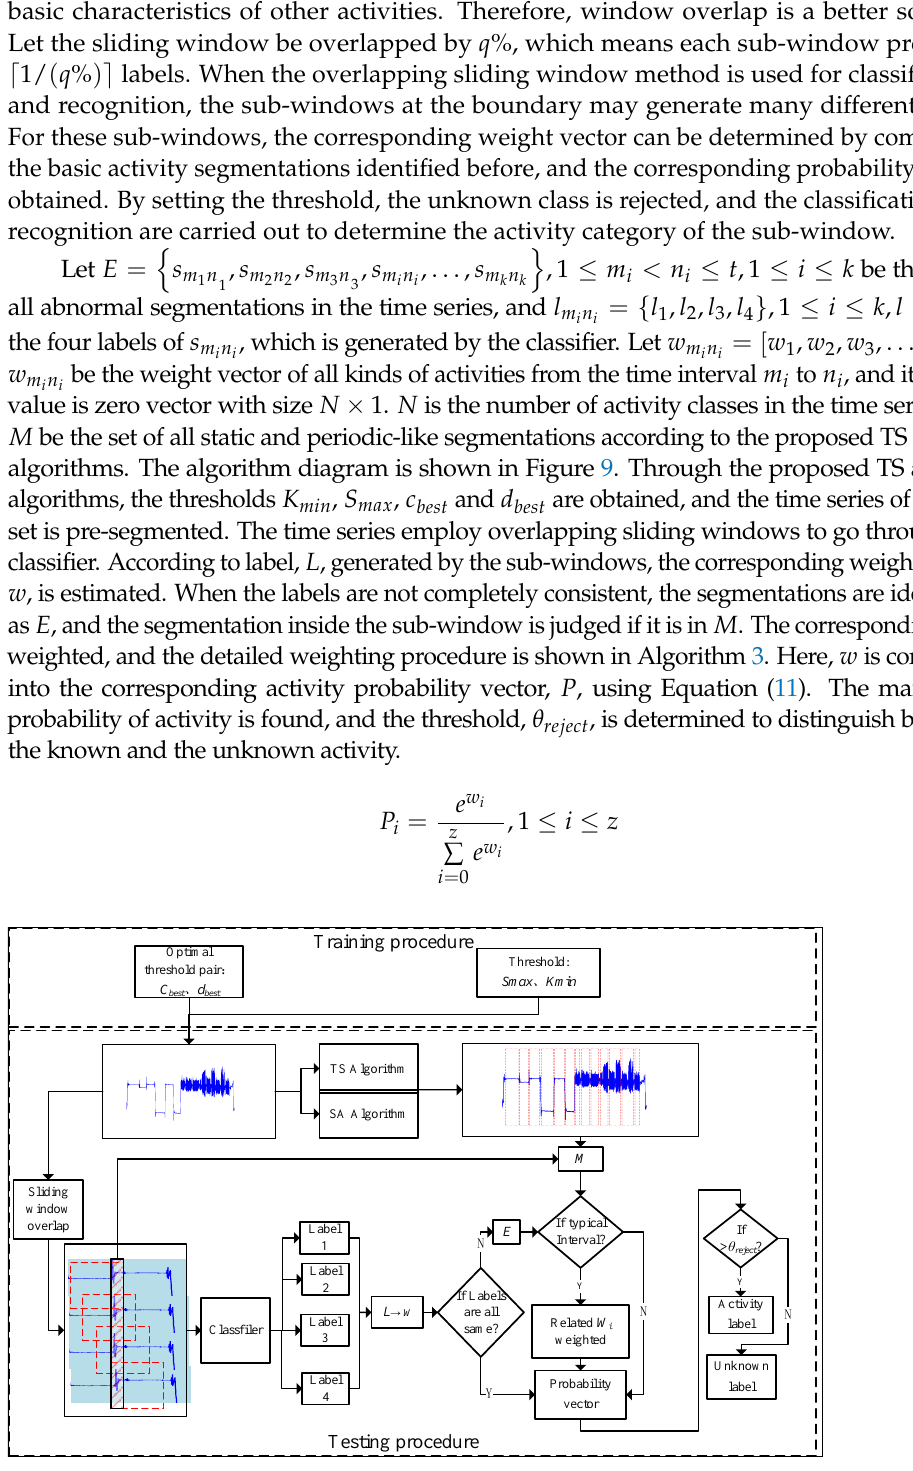
Figure 9. The diagram of the proposed MLWP